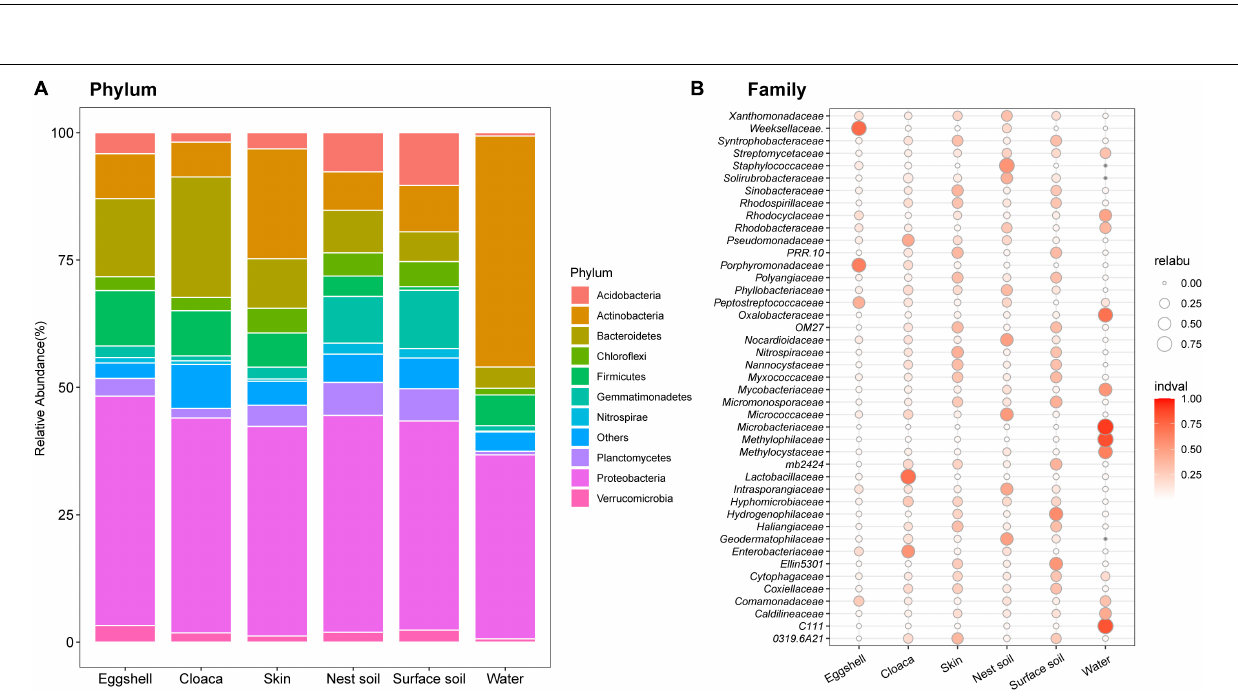
FIGURE 2 | α -Diversity across eggshells and potential sources of microbes in Chinese three-keeled pond turtle. Observed richness (A) and Shannon diversity (B) of microbiomes from eggshells, maternal sources (cloaca and skin), and environmental sources (nest soil, surface soil, and pond water). Significance of comparisons between eggshells and other communities is shown (Wilcox test, FDR-corrected P -values, * P < 0.05, ** P < 0.01, *** P < 0.001, ns not significant). Box centerlines, edges, whiskers, and points signify the median, interquartile range (IQR), 1.5 × IQR, and > 1.5 × IQR, respectively. **** P < 0.0001.